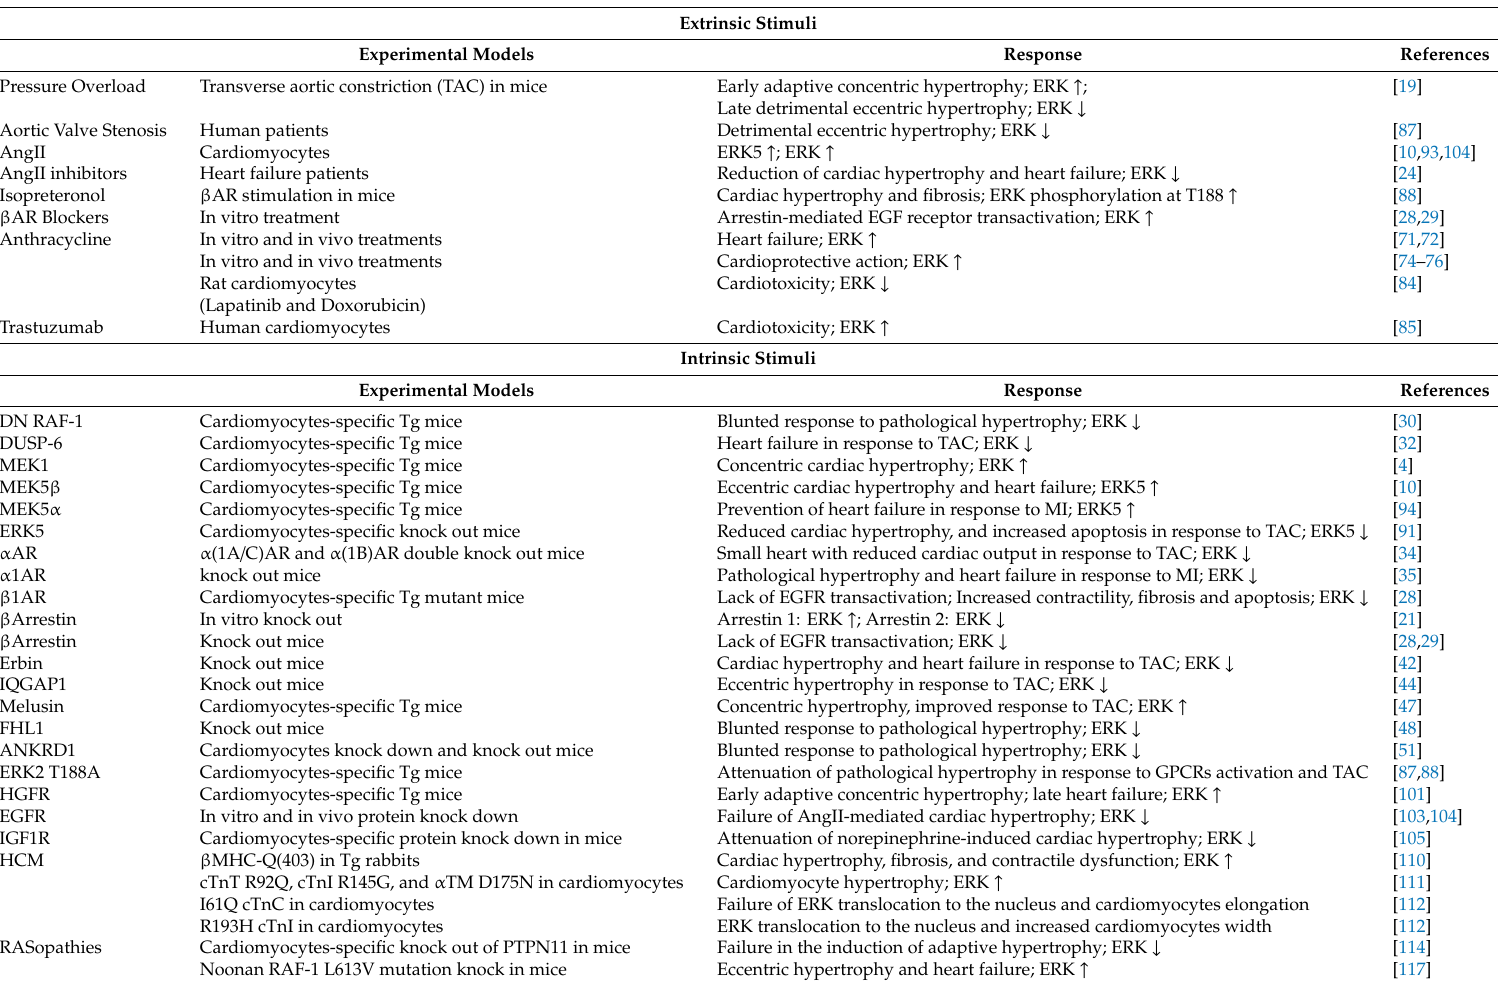
Table 1. Modulation of ERK signaling by extrinsic and intrinsic